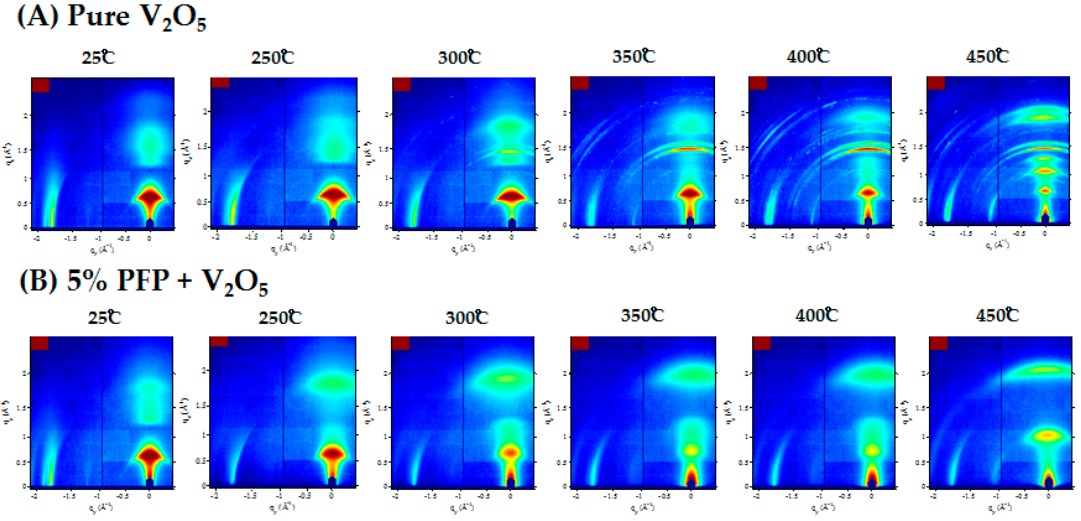
Figure 3. Grazing-incidence X-ray-scattering (GIWAXS) 2-D images with ex situ thermal annealing from 25 °C to 450 °C for ( A ) pure V 2 O 5 and ( B ) V 2 O 5 blended with 5% PFP.